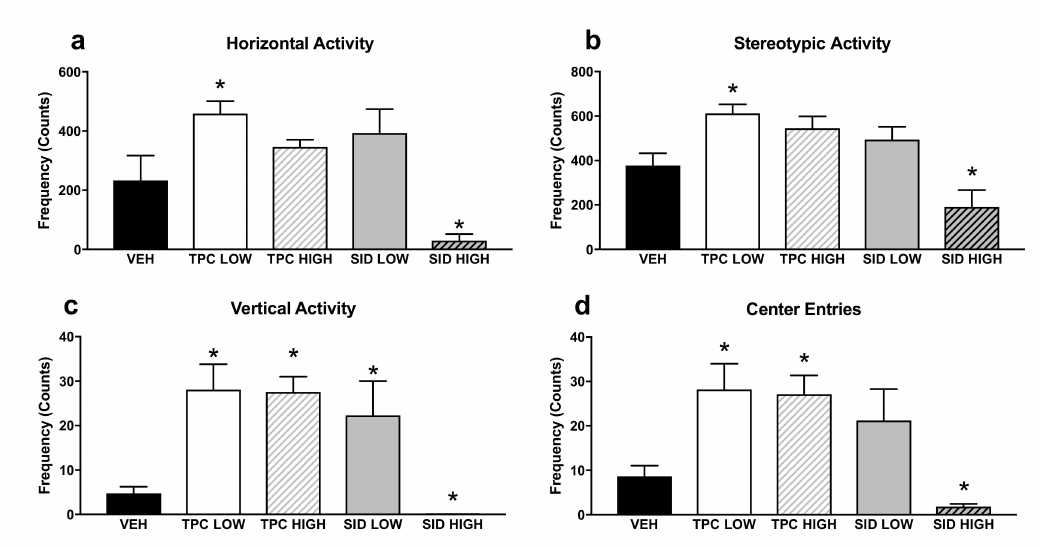
Figure 2. Open Field test horizontal ( a ), stereotypic ( b ) vertical ( c ) activity and center entries ( d ) in the Open Field. TPC Low Dose = 10 mg / kg, High Dose = 30 mg / kg, SID Low Dose = 50 mg / kg, High Dose = 150 mg / kg. N = 7–9 / group. An asterisk denotes a significant di ff erence between a treatment group and the corresponding vehicle-treated control